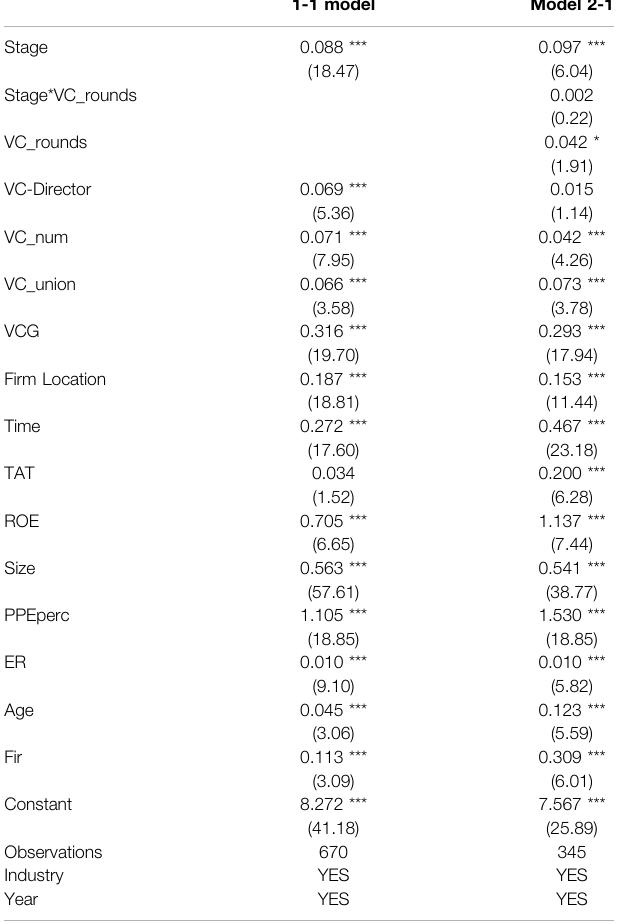
TABLE 14 | Regression results by